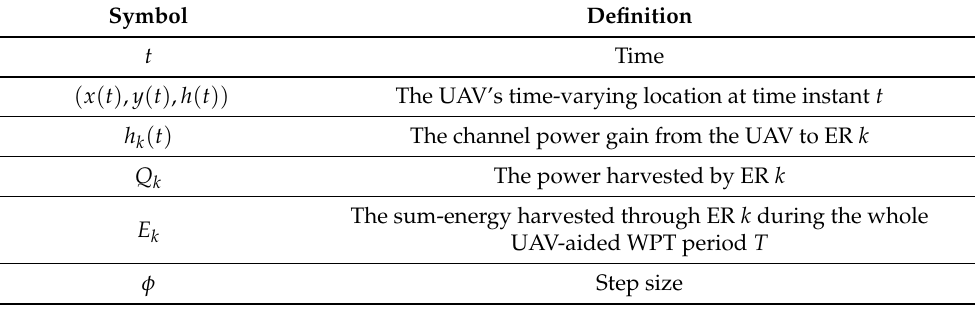
Table 1. Summary of main notations.